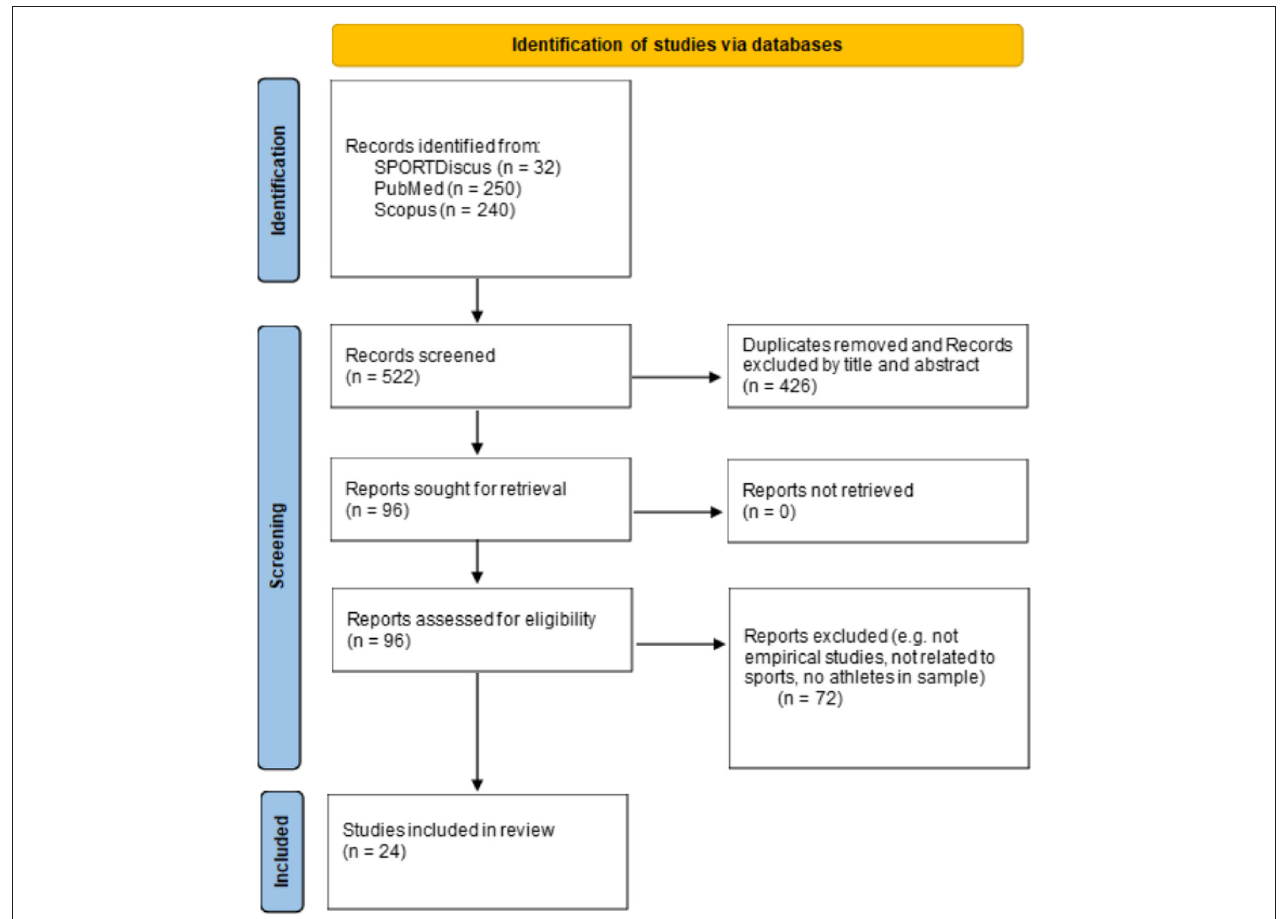
FIGURE 1 | Flow chart of the scoping review process, adapted from Page et al.